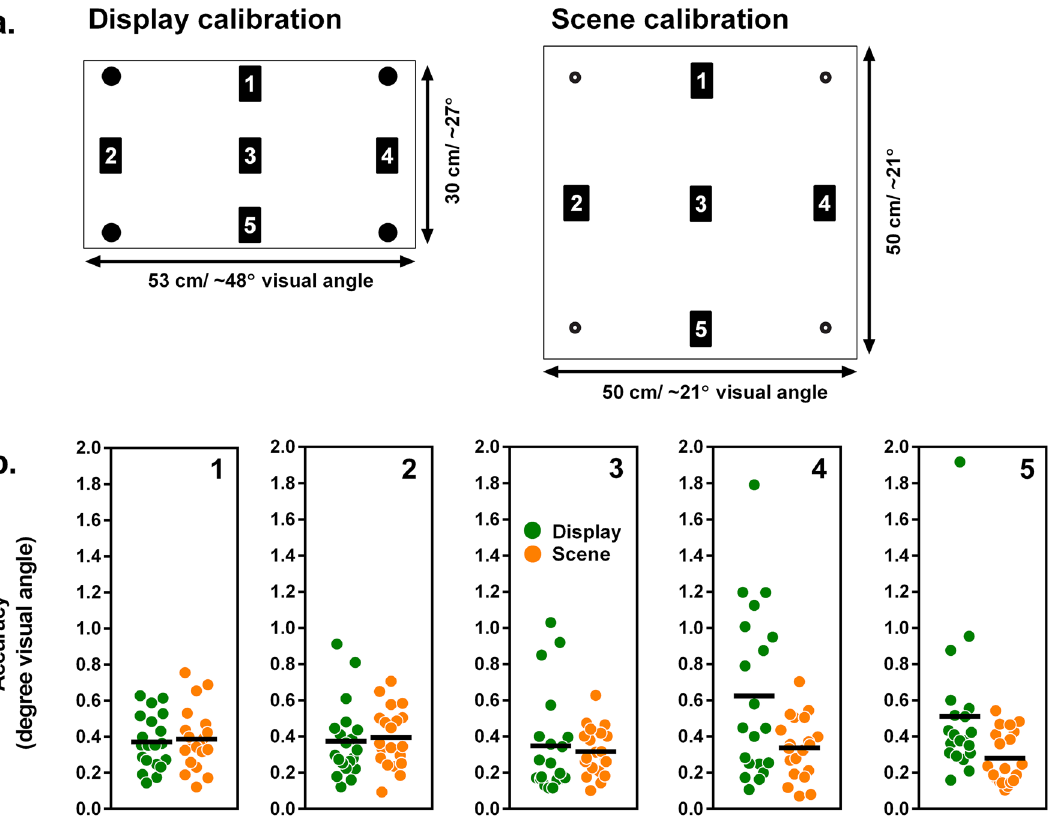
Figure 2. Accuracy for display and scene condition at different target locations. ( a ) Size and target location for display and scene calibration. ( b ) Accuracy in degrees visual angle. Black lines represent mean values. Lower values represent better